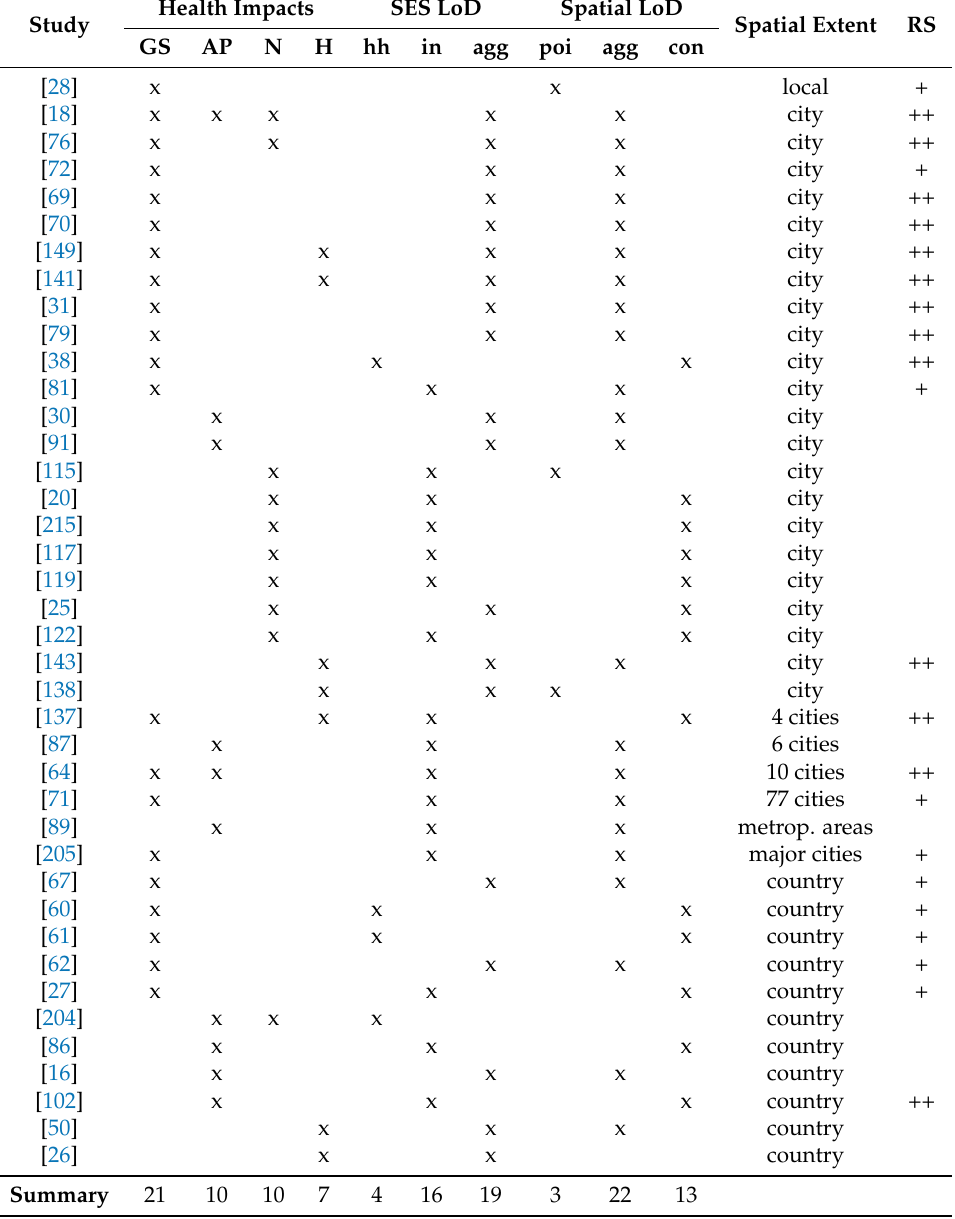
Table 1. Selected studies which deploy spatial analysis of environmental burdens or benefits. The most commonly studied health impacts include green space (GS), air pollution (AP), noise (N), and heat (H). The levels of detail (LoD) are summarized on household (hh), individual (in), or aggregated (agg) level for socioeconomic status (SES), and for spatial data as point (poi), aggregated (agg), or continuous (con) information, respectively. Where applicable, it is indicated whether remote sensing techniques (RS) were used to derive environmental parameters directly (++) or indirectly